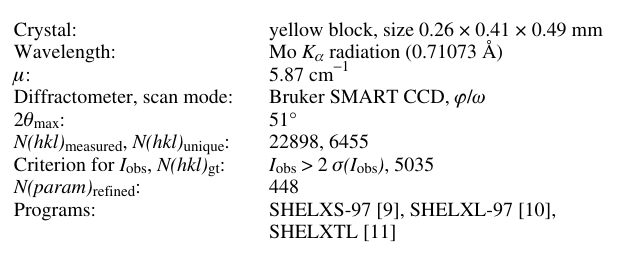
Table 1. Data collection and handling.